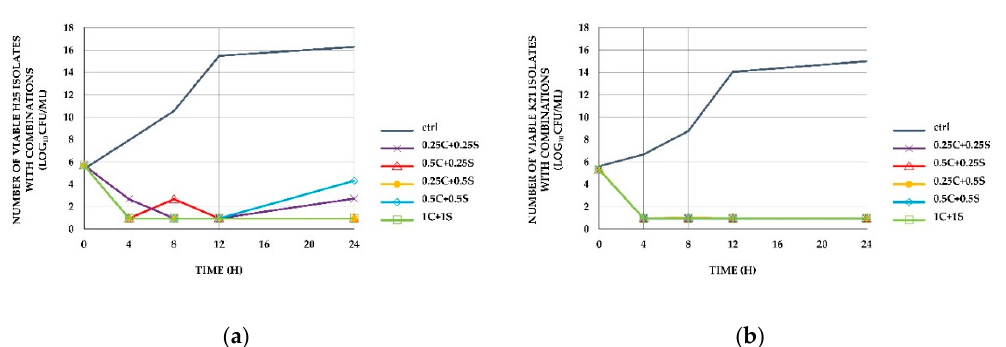
Figure 2. Time-kill curves of A. baumannii clinical isolates. ( a ) Time-kill studies of the H25 isolate with combinations, ( b ) the K21 isolate with combinations. The number of viable bacteria from the start of the experiment is shown. Ctrl represents control isolates (no antimicrobial agents). C represents the MIC of colistin as single agent. S represents the MIC of sitafloxacin as single agent. For example, 0.25C + 0.25S represents 0.25× MIC of colistin as single agent with 0.25× MIC of sitafloxacin as single agent. The blue-grey lines represent control isolates. The purple lines with crosses represent 0.25C + 0.25S, the red lines with triangles represent 0.5C + 0.25S, the yellow lines with filled circles represent 0.25C + 0.5S, the blue lines with diamonds represent 0.5C + 0.5S, and the green lines with squares represent 1C + 1S. C and S represent the MIC of colistin and sitafloxacin, respectively. We tested the same concentrations for both isolates and show all the curves in panel b . The lines of 0 . 25C + 0 . 25S, 0 . 5C + 0 . 25S, 0 . 25C + 0 . 5S, 0 . 5C + 0 . 5S, and 1C + 1S in panel b overlap .